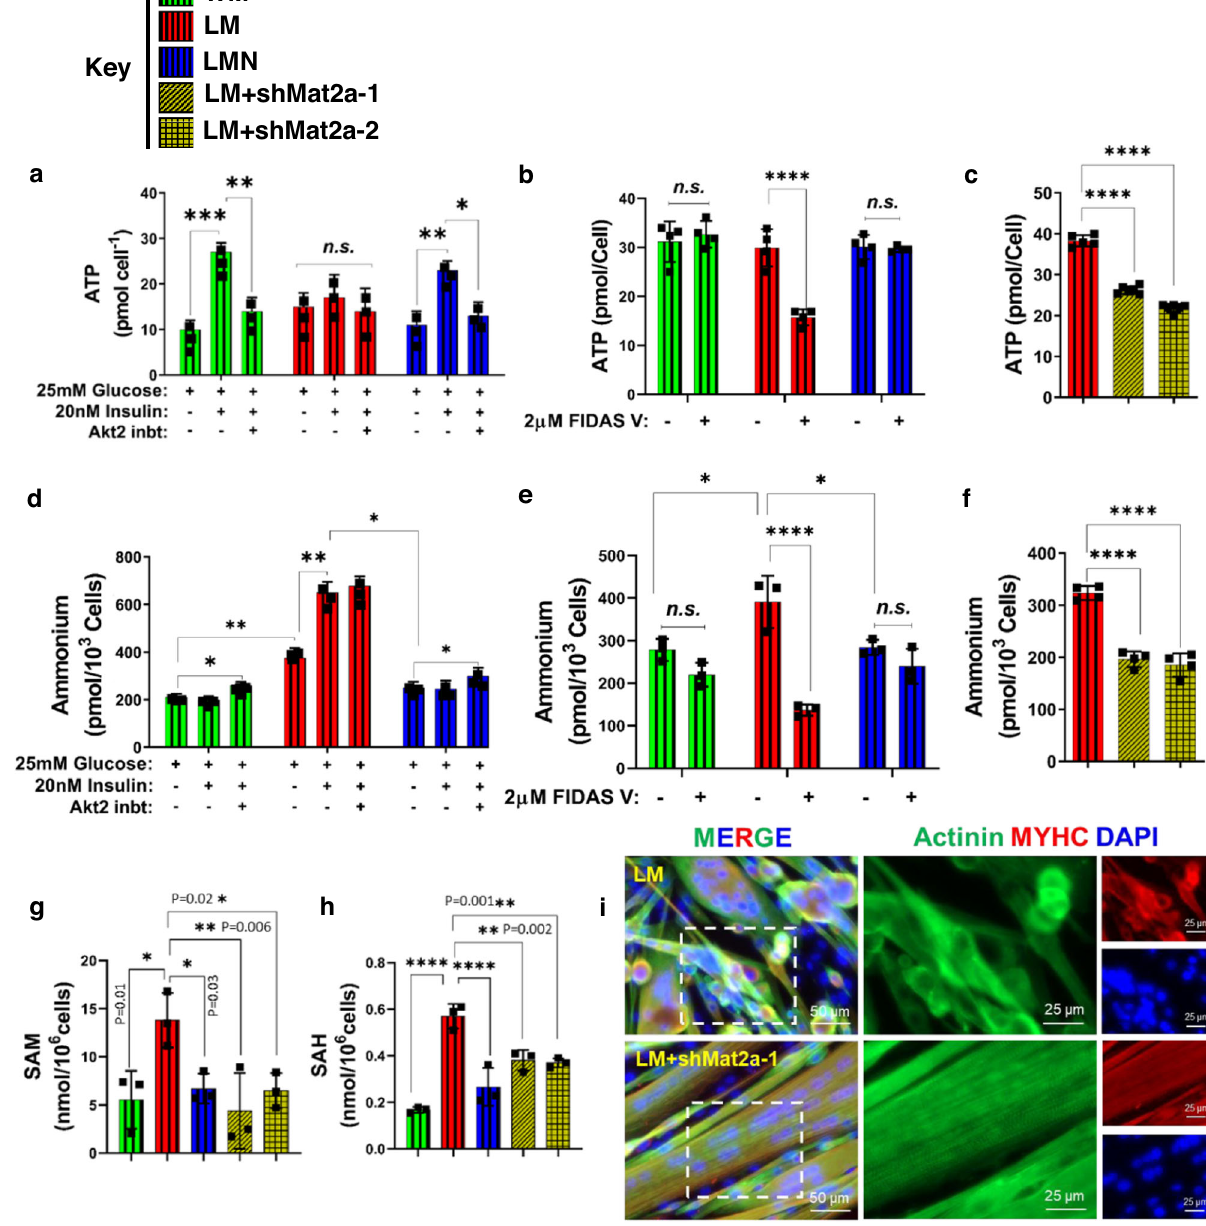
Fig. 5 | Inhibiting MAT2A decreases ammonium levels and restores differ- entiation capacity in progeric mouse myoblasts. a ATP levels in response to insulin and Akt2 inhibition. (* p =0.02, ** p =0.00076, *** p =0.0002, and ns repre- sents p >0.37) statistical signi fi cance using two-way ANOVA with Tukey ’ s multiple comparisonstest. b ATPlevelsinresponsetoMAT2AinhibitorFIDASV. c ATPlevels in LM cells with Mat2a knockdown. d Ammonium levels in response to insulin and Akt2 inhibition. (* p <0.04 and ** p <0.001) statistical signi fi cance using two-way ANOVAwithTukey ’ smultiplecomparisonstest. e Ammoniumlevelsinresponseto MAT2A inhibitor FIDAS V. For plots b and e statistical signi fi cance using two-way ANOVA with Sidak ’ s multiple comparisons test. (* p <0.04, **** p <0.0001, and ns